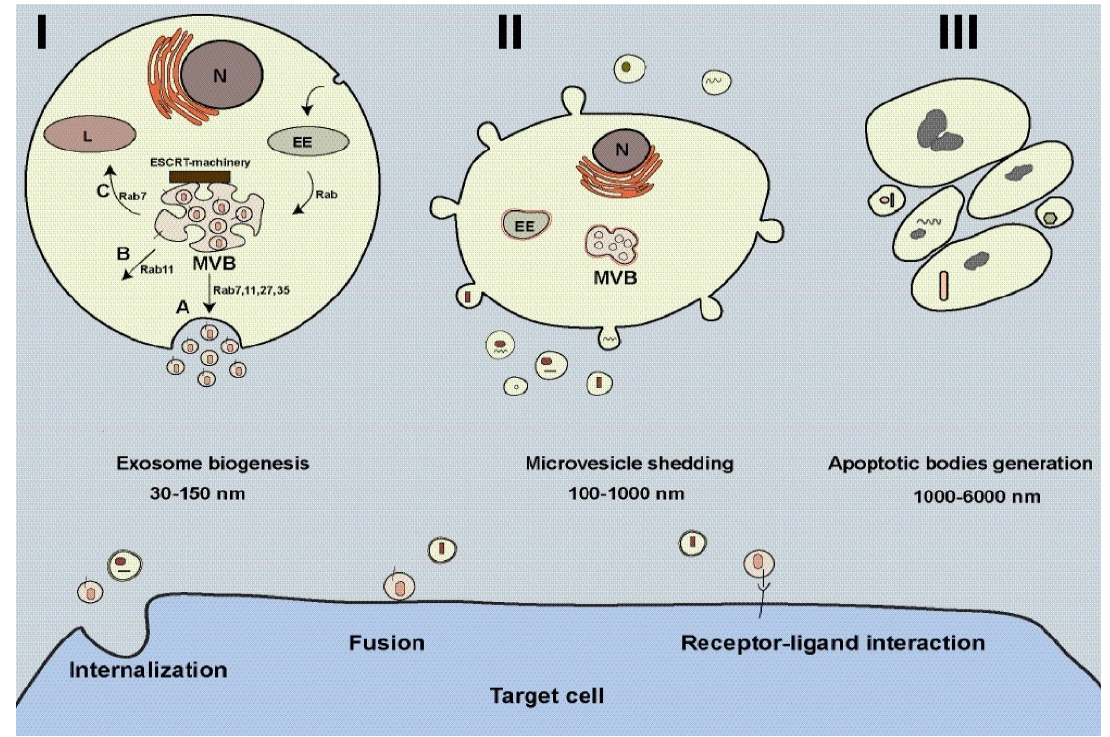
Figure 1. Biogenesis of extracellular vesicles (EVs) from cells. Exosome biogenesis is complex; dif- ferent molecules contribute to biogenesis, trafficking, and section of exosomes ( I ). Exosomes are